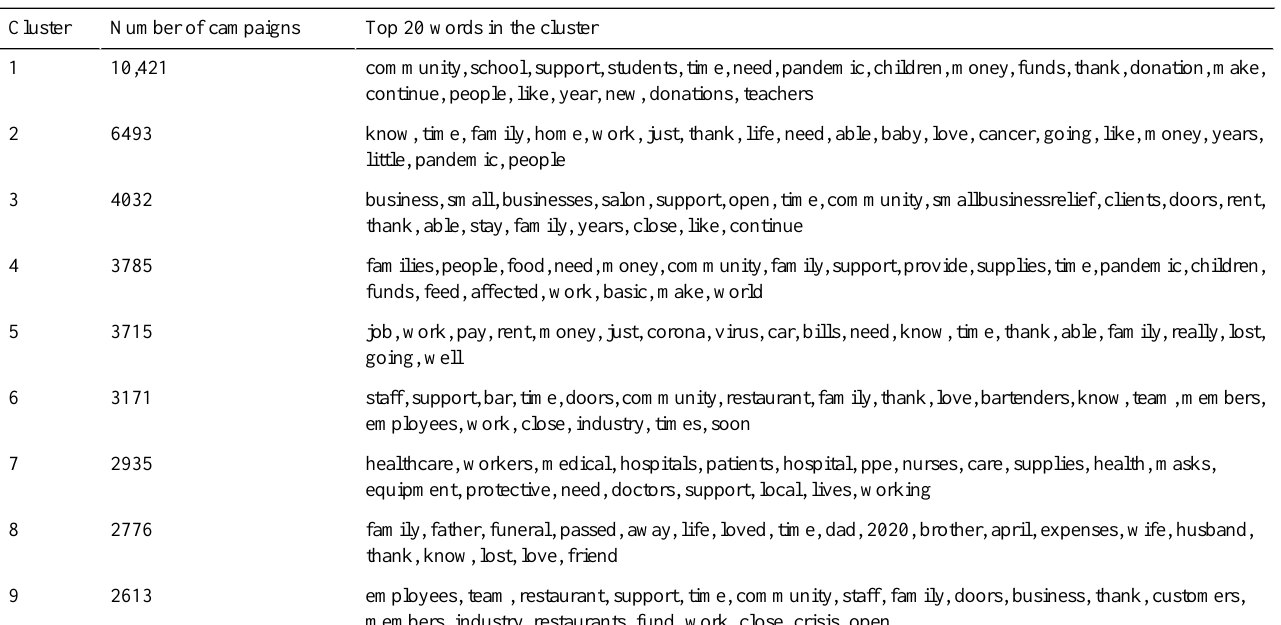
Table 2. Keywords at the center of the 19 clusters of campaigns obtained through the term frequency–inverse document frequency natural language processing technique and k-means clustering. The top 20 words for each cluster and the number of campaigns per cluster are displayed. Top 20 words in the clusterNumber of